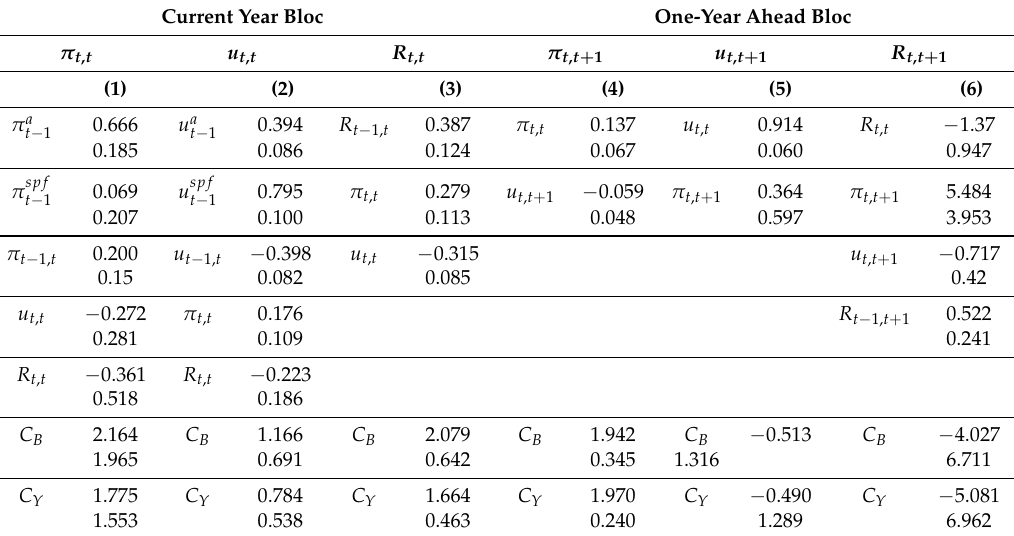
Table 2. FIML Estimation Results of Parameters of Structural Model: 2012–2017.